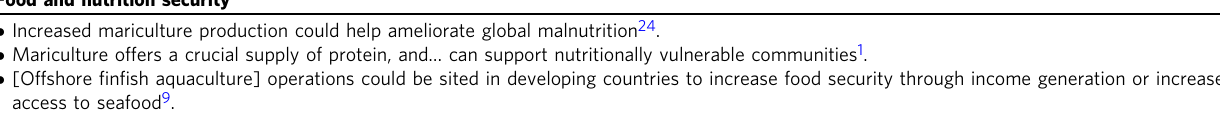
Table 2 Recent statements about marine aquaculture, food and nutrition security, and environmental sustainability. Food and nutrition